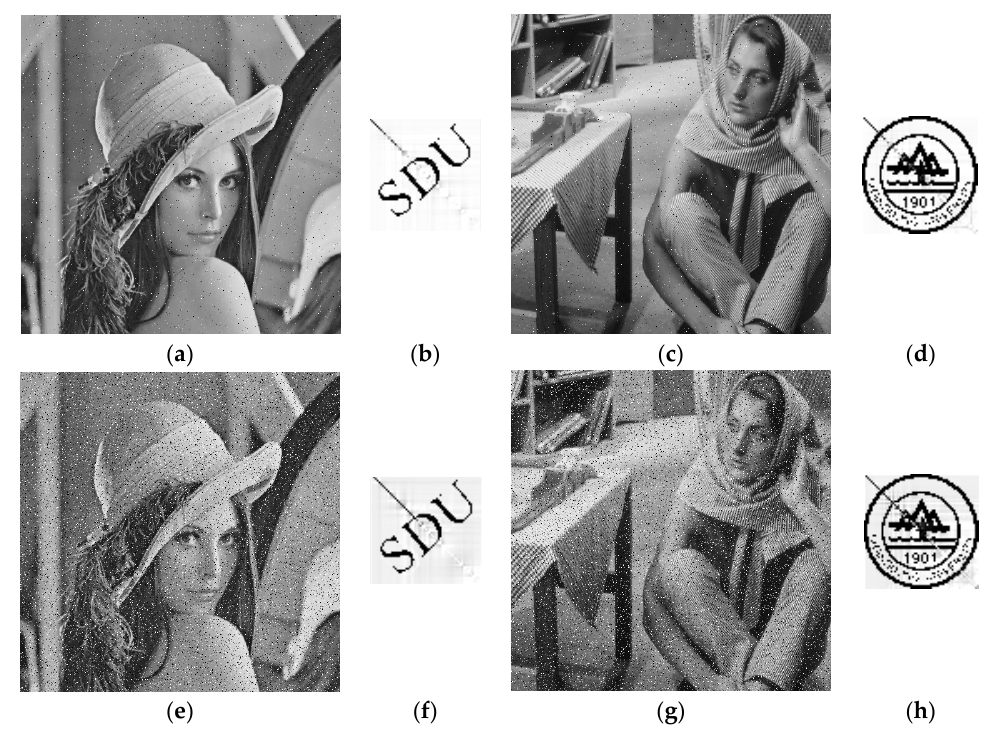
w ; 1 w ; 2 w ; 1 w ; 2 w ; 1